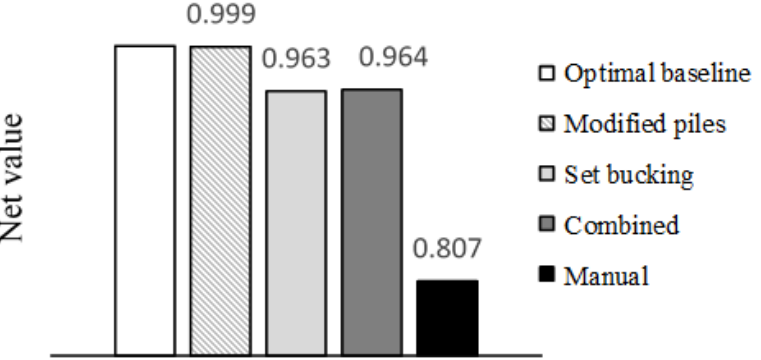
Figure 4. Relative variation of net value with scenarios in comparison to the optimal scenario. Table 4. Revenues and costs variations for selected scenarios in comparison to the optimal scenario (set at 1.000).